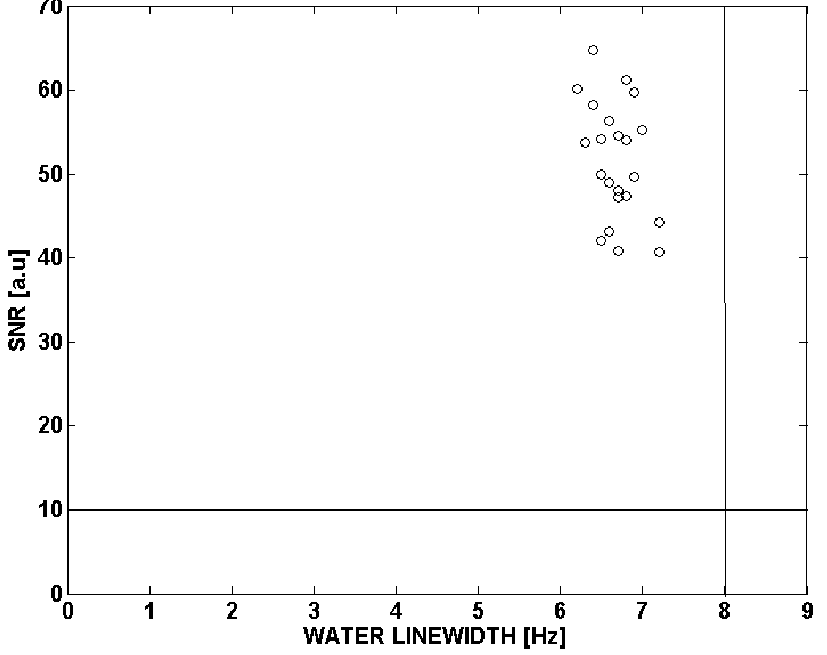
Figure 2. Overview of evaluated spectral qualities. Solid lines for FWHM (=8 Hz) and SNR (=10) criteria are drawn in the Figure. All 22 spectra are distributed in the satisfied region.